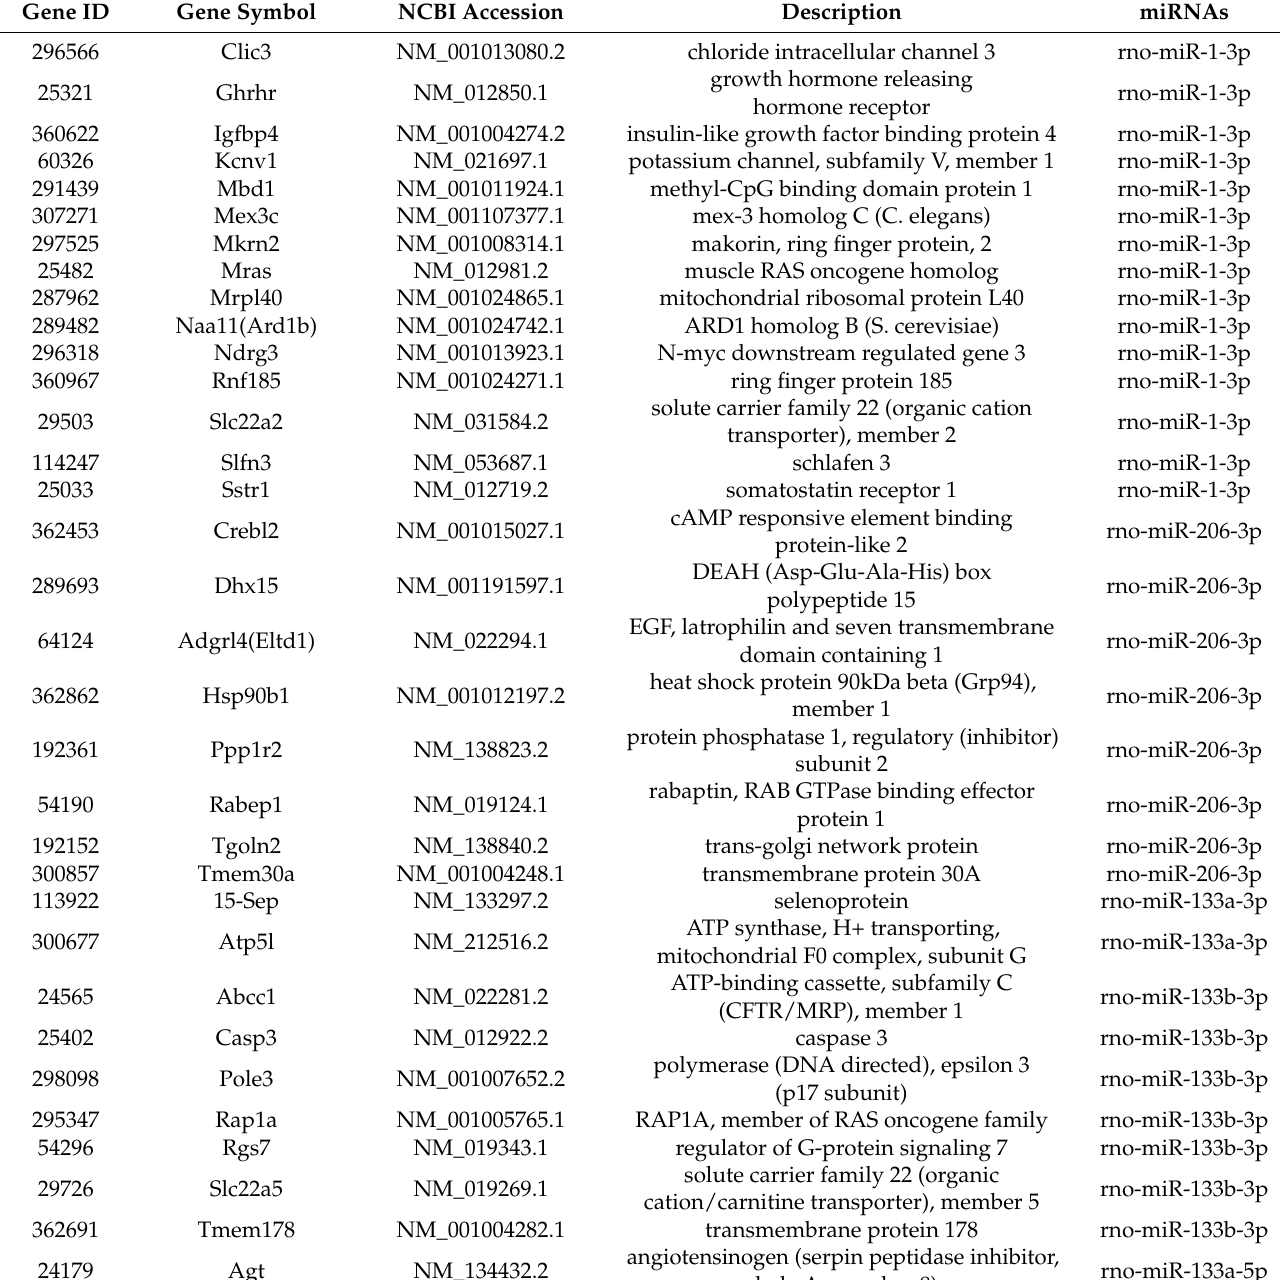
Table 4. Predicted target genes of differently expressed miRNAs.